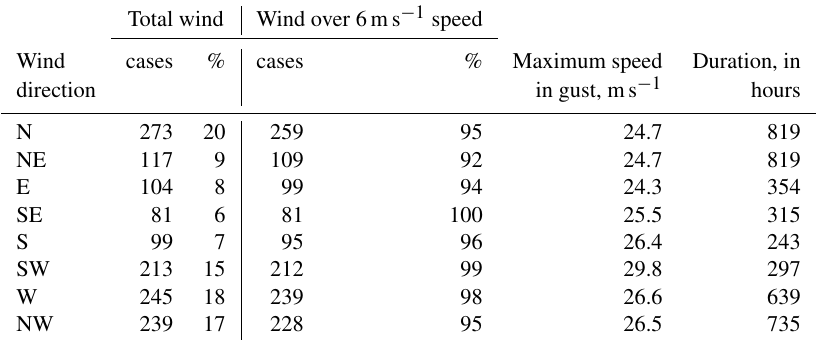
Table 1. Wind speed and number of cases in March–October 2016 year (data from the Nida meteorological station). Total